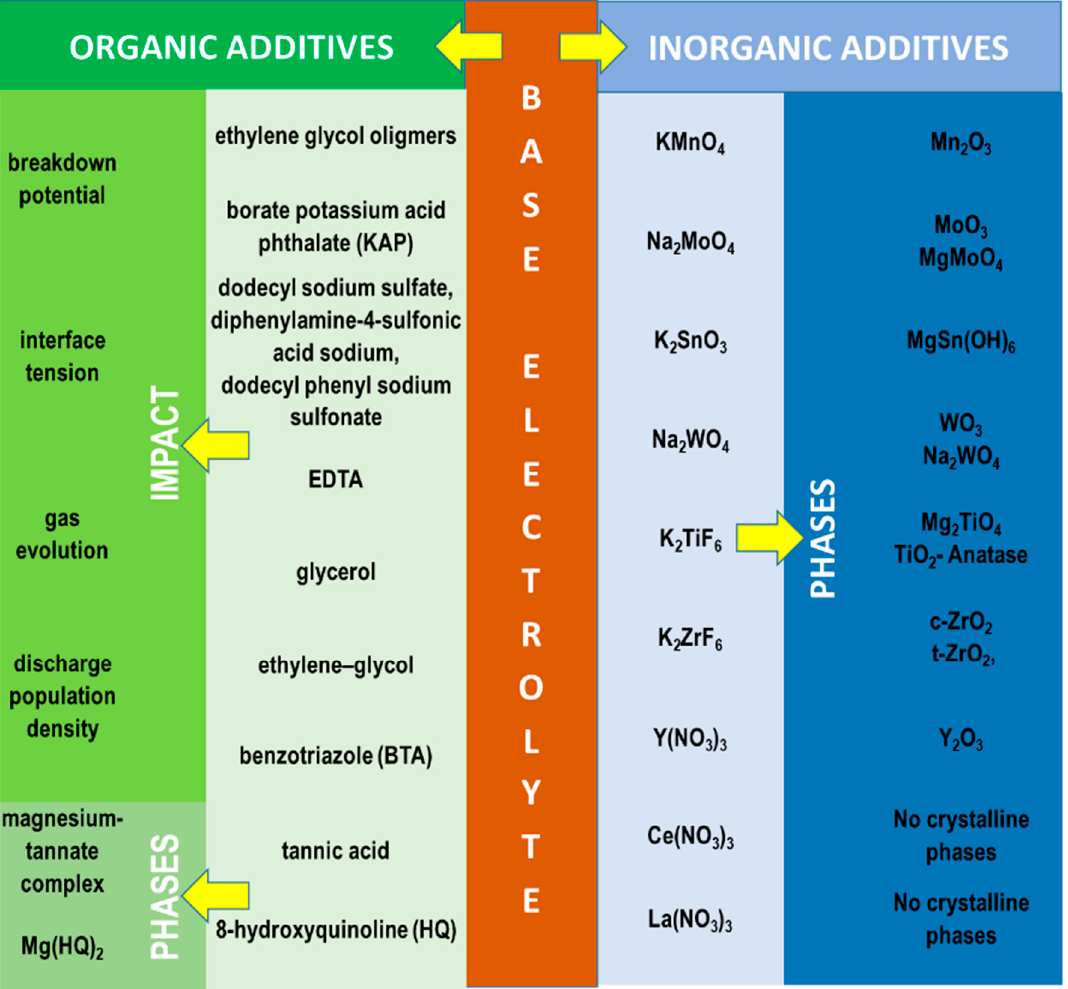
Figure 12. Schematic of soluble organic and inorganic substances added to PEO electrolytes and their effect on the resulting coatings.